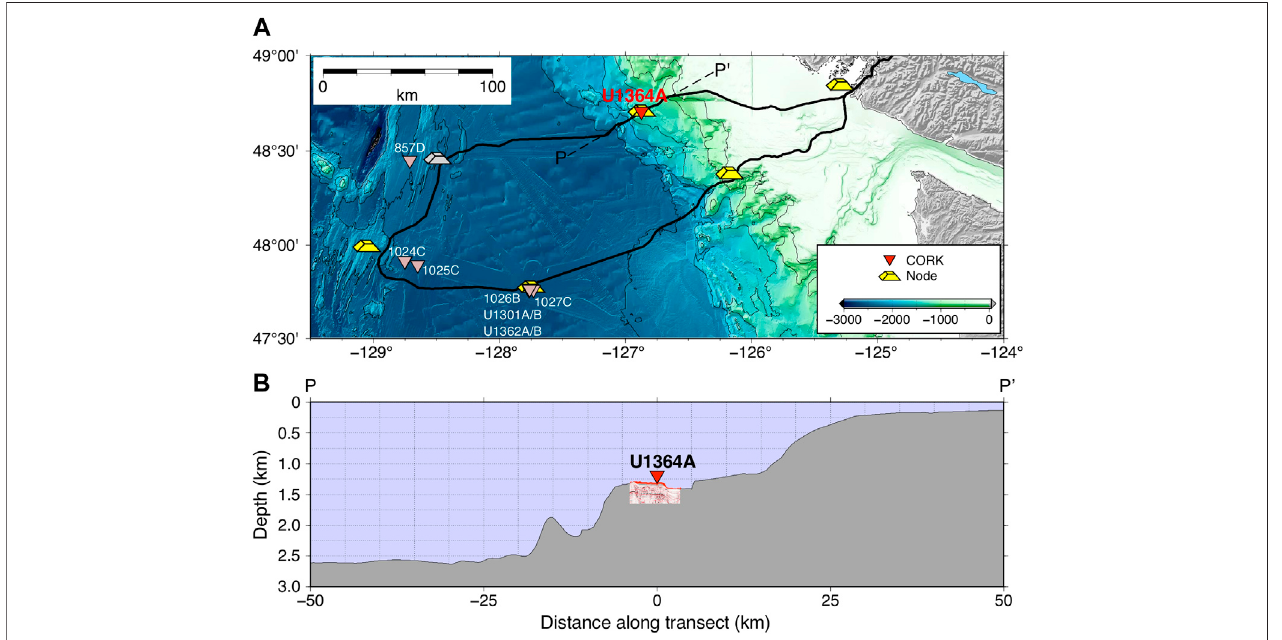
FIGURE1| (A) Location ofHole U1364A,Ocean Networks Canada (ONC) cabled observatorynodes, and other CORK sites inthenortheast Paci fi c. (B) Location of Hole U1364A along bathymetric pro fi le P-P ′ shown in (A) . An expanded version of the small seismic section in the vicinity of Hole U1364A is shown in Figure 3 .